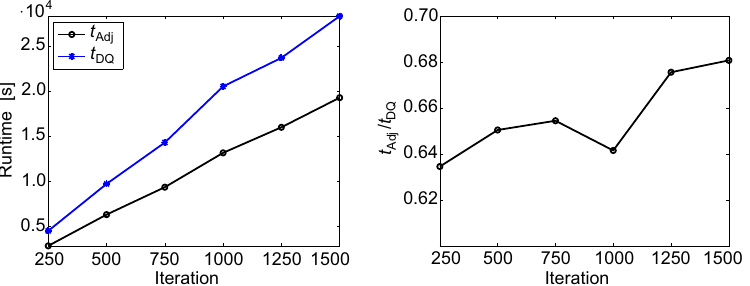
Figure 6. The runtime of calculating gradients using the adjoint method t Adj and using difference quotients t DQ . On the left side, the dependence on the number of time iteration steps is presented. On the right side, the ratio of the runtimes is